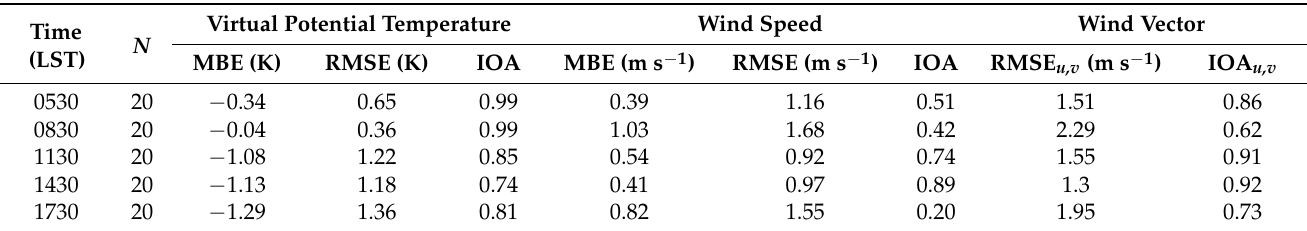
Figure 5. The 3-hourly vertical profiles of ( a ) virtual potential temperatures and ( b ) wind vectors at the BSWO from 05:30 to 17:30 LST on 15 July 2018 for observations and the default simulation (S04V). The prefixes O and M of the legend in ( a ) represent observations and simulations, respectively. Table 4. Model evaluation statistics for the 3-hourly vertical profiles of virtual potential temperature and winds below 2 km AGL against the observations from the radiosonde at the BSWO from 05:30 to 17:30 LST on 15 July 2018. MBE, RMSE, and IOA indicate the mean bias error, root-mean-square error, and index of agreement, respectively. N represents the number of